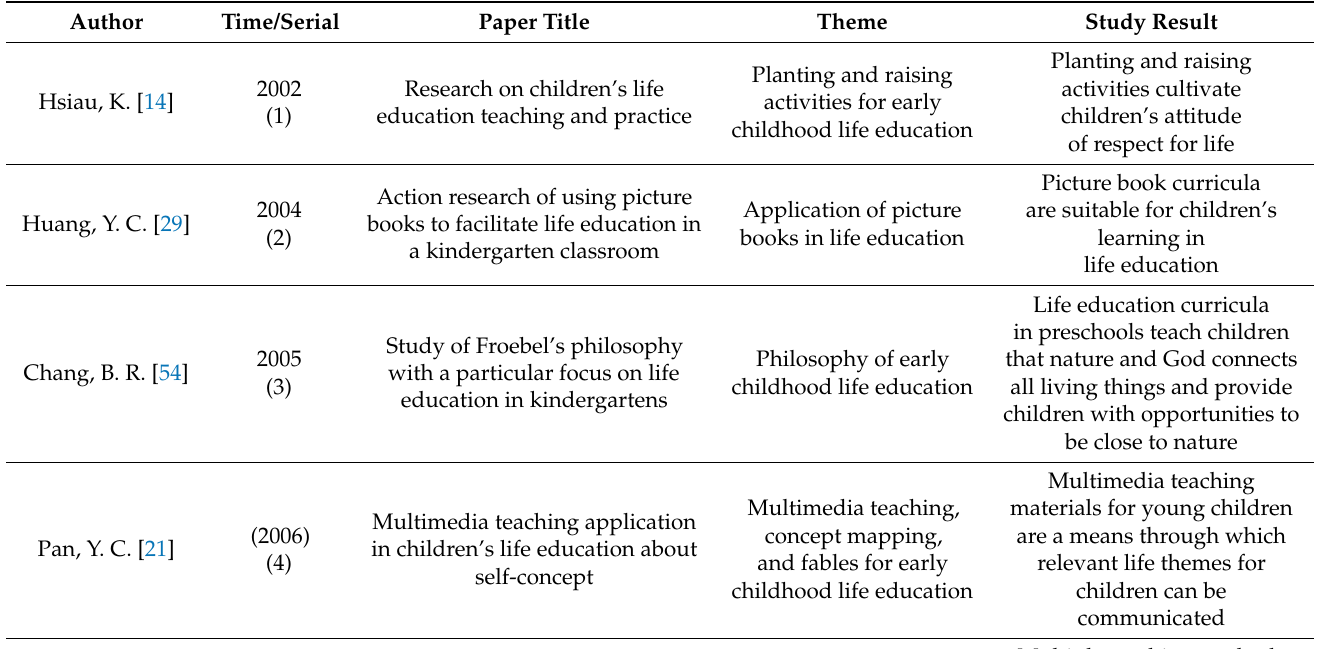
Table A1. Studies on life education for young